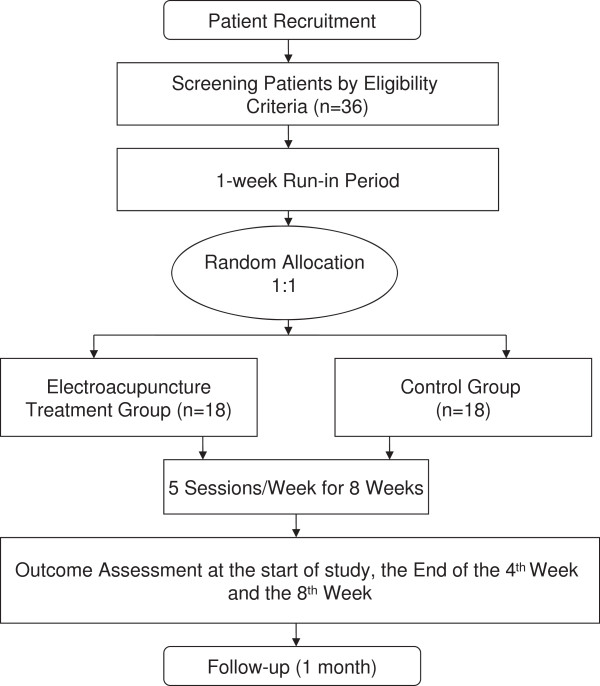
Trial flow chart.